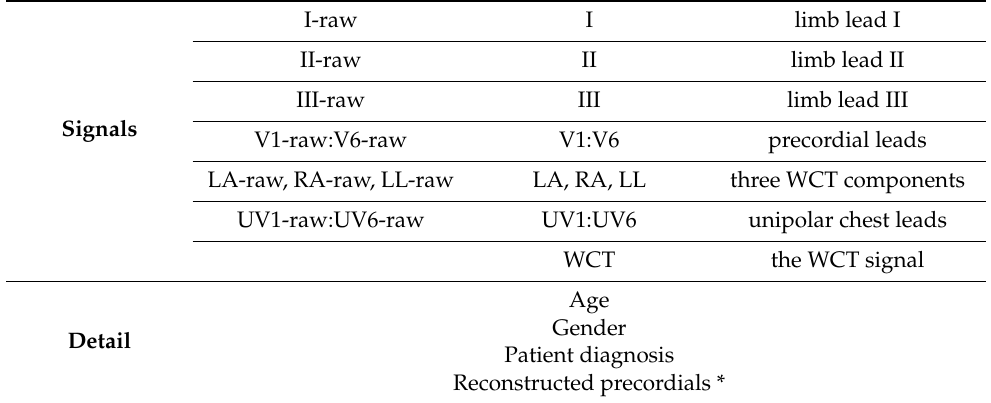
Table 1. The signal names and the detail of the recording presented for each segment.